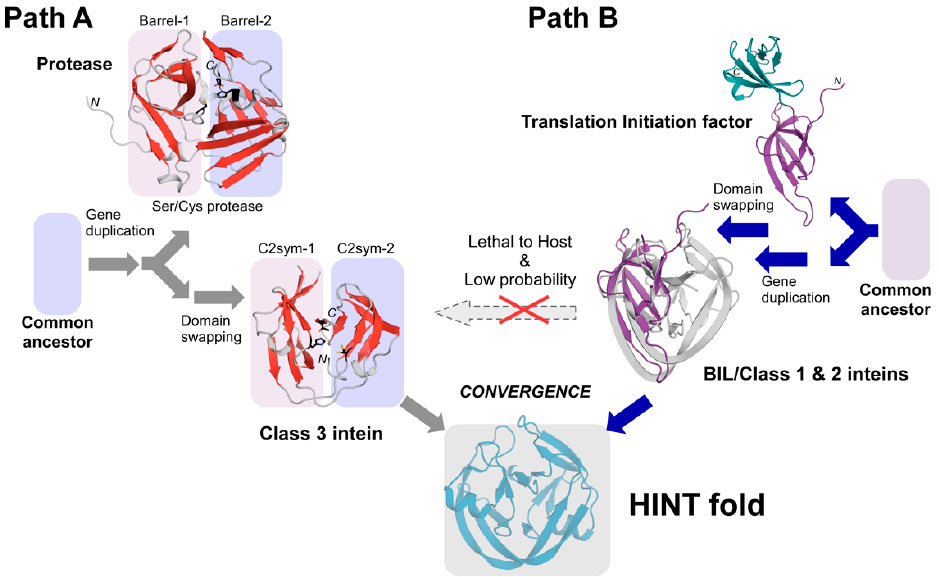
Figure 6. Evolution model of the HINT fold. ( A ) Class 3 inteins may have evolved from an ancestral cysteine protease originating from prophages, retaining the highly conserved catalytic triad. Boxes indicate two sub-domains of a cysteine protease (TEV protease, 1lvm) and the pseudo-C2-symmetry relation in a class 3 intein ( Mch DnaB1 intein, 6rix). ( B ) Other members of the HINT superfamily might have evolved via a very different pathway from a distantly related ancestral protein such as a translation initiation factor by gene duplication, fusion, and domain swapping. Cartoon drawings of translation initiation factor (IF5A, 1bkb) [41] and the superposition with the pseudo-C2-related subdomain of the BIL domain (2lwy) [16] are shown (Supplemental Table S2). The purple N-terminal domain of IF5A was superimposed with the HINT domain.